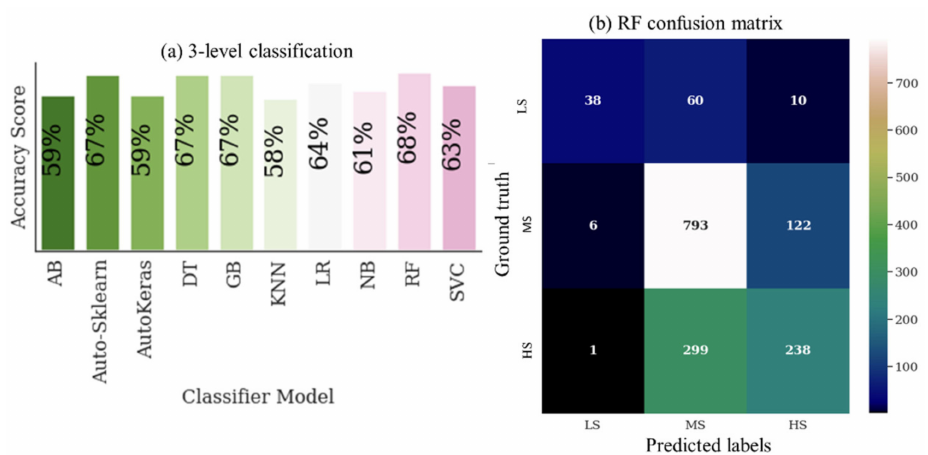
Figure 6. ( a ) Three-level accuracy performance. ( b ) Confusion matrix for